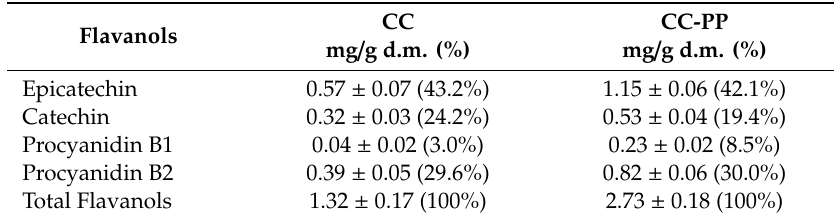
Table 1. Phenolic composition of cocoa products (conventional soluble cocoa -CC- and flavanol-rich soluble cocoa -CC-PP-) determined by high-performance liquid chromatography-diode array (HPLC-DAD). Flavanols